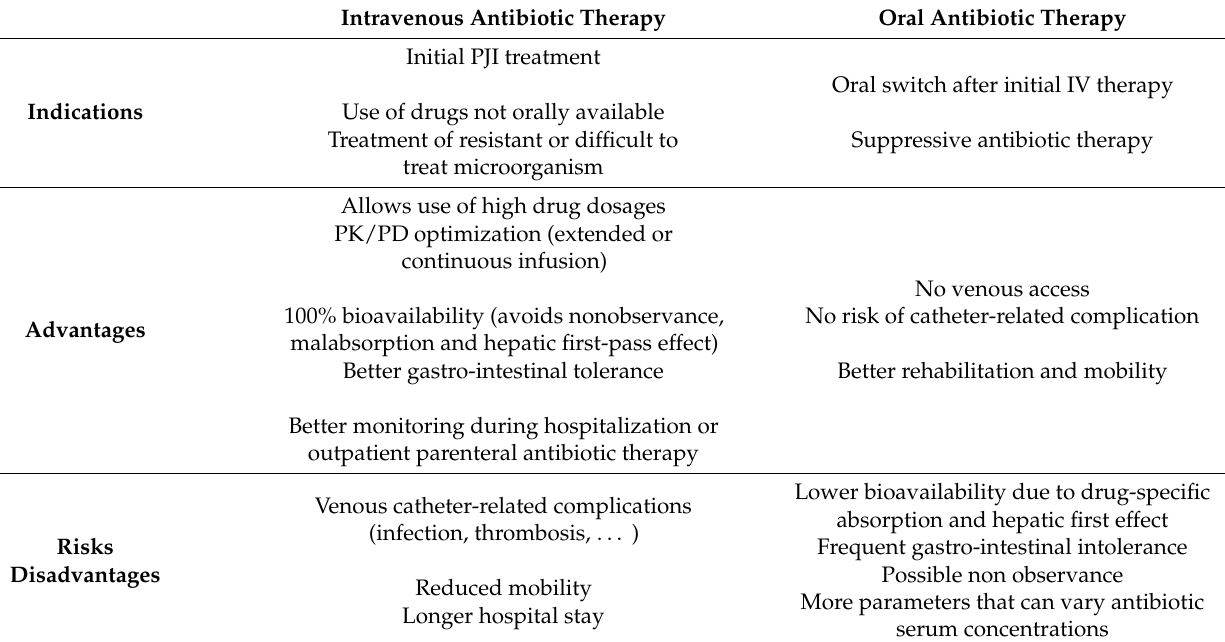
Table 1. Indications, advantages and risks of IV versus oral antibiotic